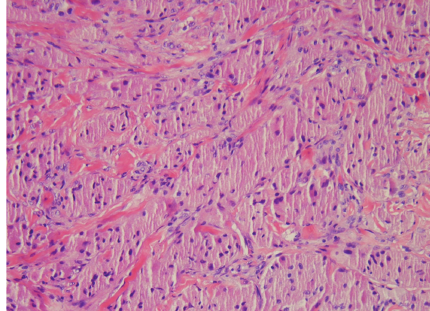
Figure 2: (Hematoxylin and eosin original magnification, 400x). The classic granular cell tumor, composed of a collection of polygonal or round cells with centrally placed nuclei and coarsely granular eosinophilic cytoplasm. Note the lack of nuclear atypia and mitotic